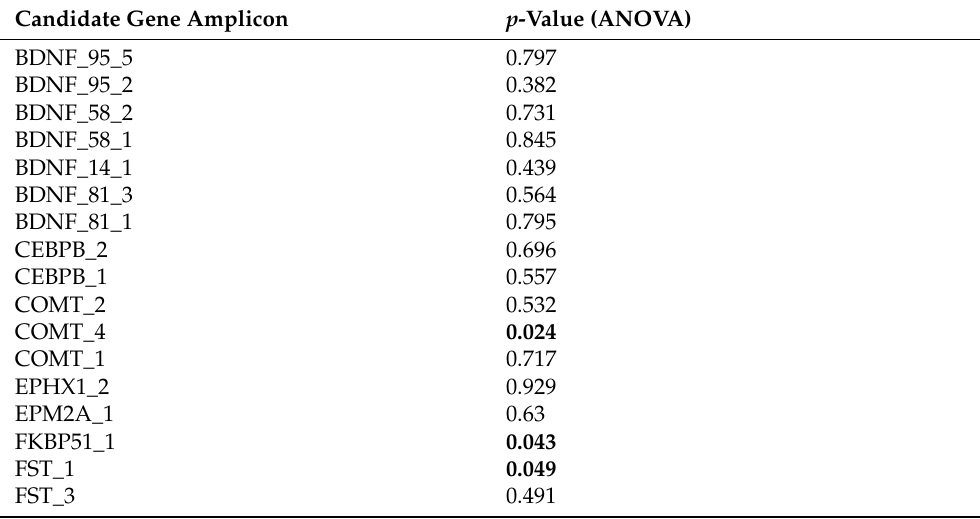
Table 4. p -values for significant interaction of group and time for methylation of candidate gene amplicons. Table contains only amplicons where the average DNA methylation values could be calculated from available data. Statistically significant p-values are marked in bold.